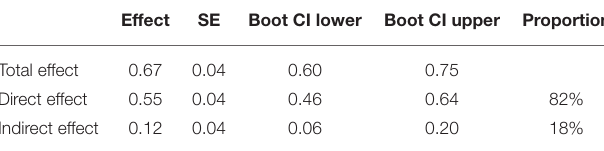
TABLE 2B | The Bootstrapping analysis of the mediating effects. TABLE 3A | Results of emotional intelligence moderate the mediation